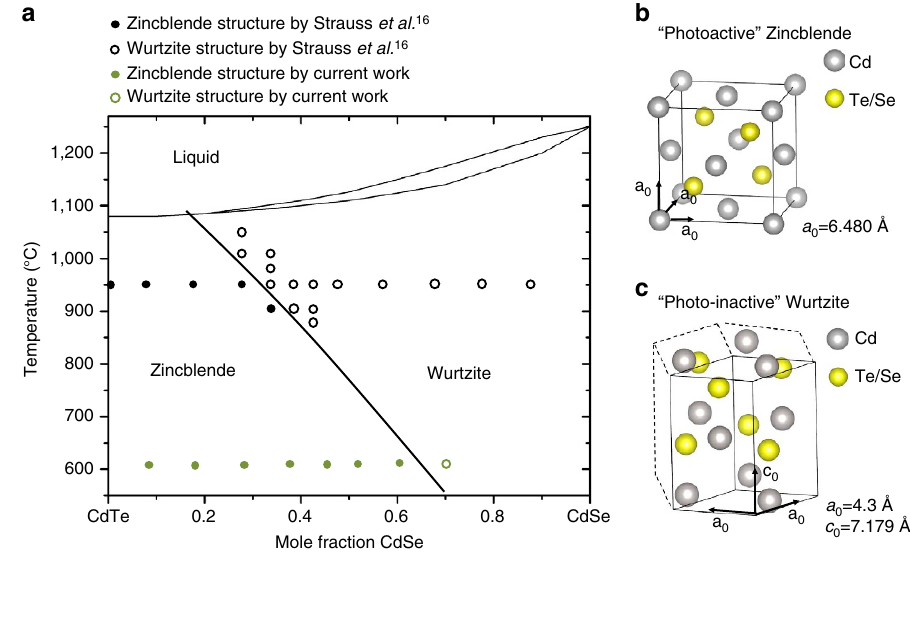
NATURE COMMUNICATIONS|7:12831|DOI: